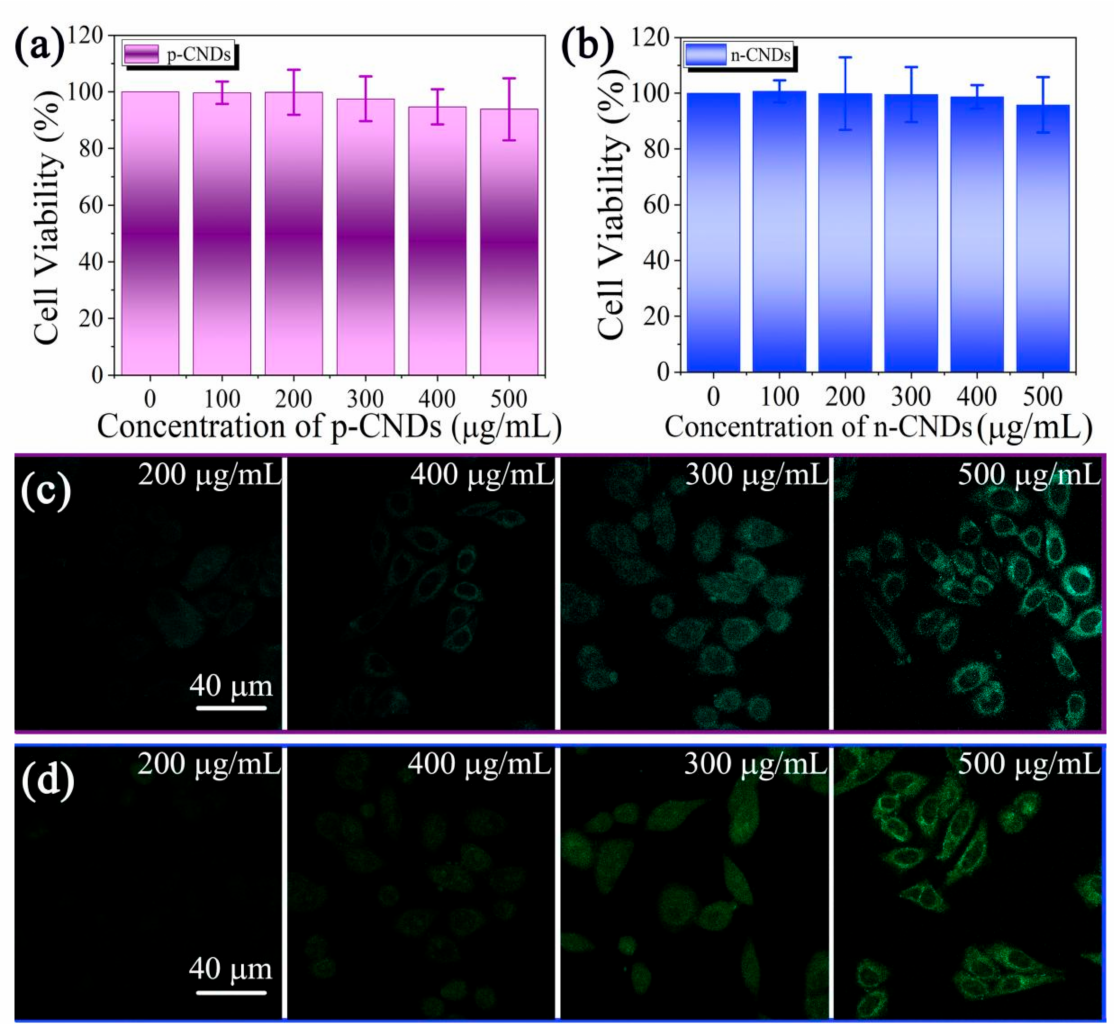
Figure 5. Cytotoxicity of ( a ) p-CNDs and ( b ) n-CNDs on HeLa cells after incubation for 24 h. Control group: HeLa cells without CNDs. ( c ) Confocal fluorescence images of HeLa cells after culturing with 200 µ g mL − 1 , 300 µ g mL − 1 , 400 µ g mL − 1 , 500 µ g mL − 1 of ( c ) p-CNDs and ( d ) n-CNDs for 4 h,